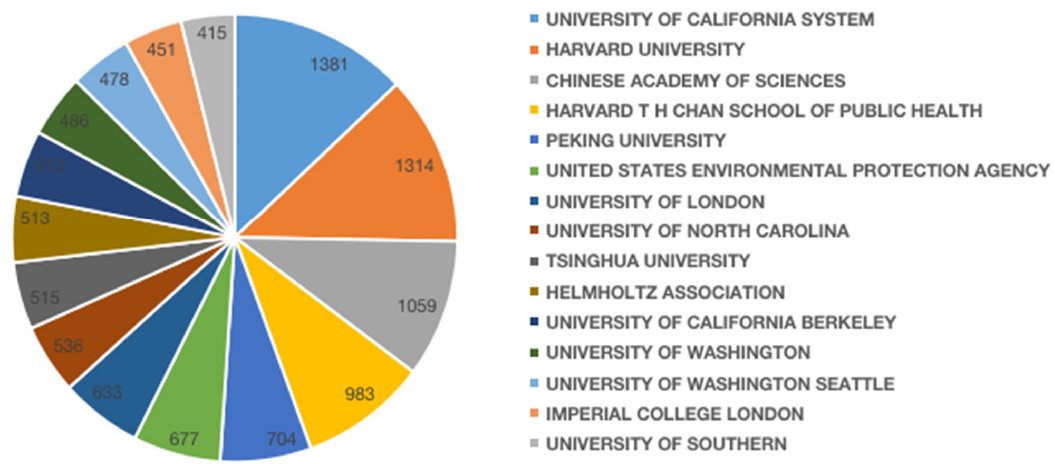
Figure 6. English publication institutions of air pollution and health research.